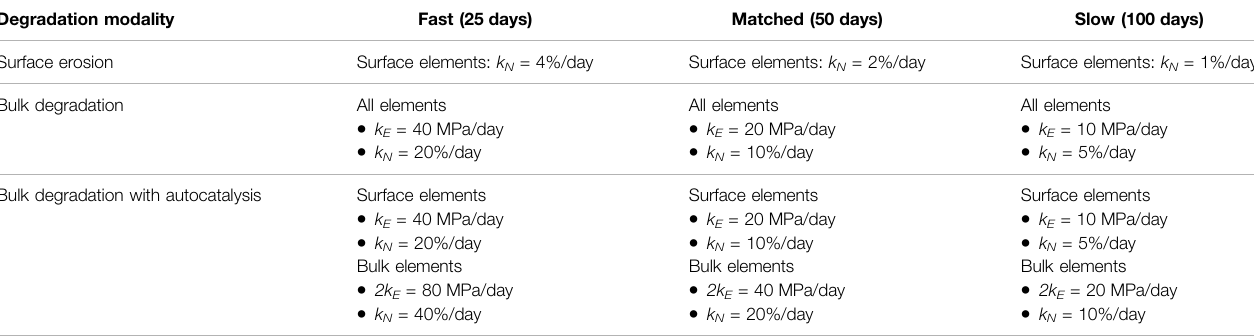
TABLE 4 | Degradation rates of volume fraction ( k N ) and elastic modulus ( k E ) of scaffold material for the three degradation modalities and the three degradation speeds investigated withthe “ arti fi cial ” scaffold.Thetimeofcompletescaffolddegradationforeachdegradationspeedisindicatedinbrackets.Thevolumefractionisexpressed as percentage of the volume of one